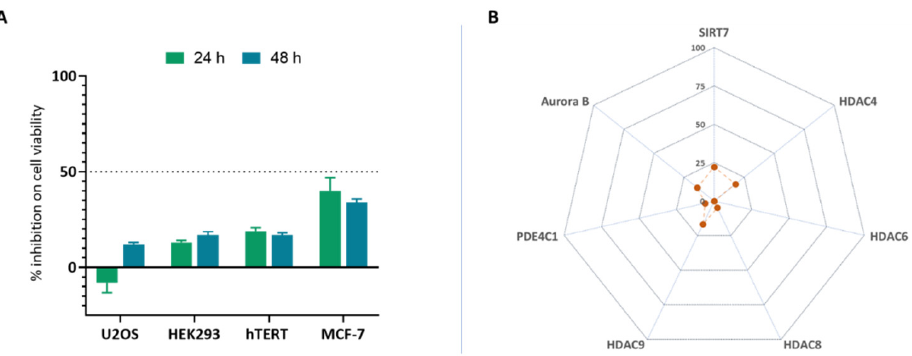
Figure 4. SG2 shows a safe toxicological profile in an in vitro panel. A panel of toxicological assays were performed to test ( A ) SG2 behaviour over cytotoxicity (U2-OS, HEK293, MCF-7, hTERT), ( B ) epigenetic modulation (HDAC6, HDAC8, SIRT7), and off-target liability (PDE4C1, Aurora B kinase). All assays were performed at 10 µM in triplicate. Raw data were normalized over positive and negative control and reported as percentage of inhibition. In no assay SG2 showed a percentage of inhibition higher than 40%, where in this profiling a value < 50% is generally considered acceptable.